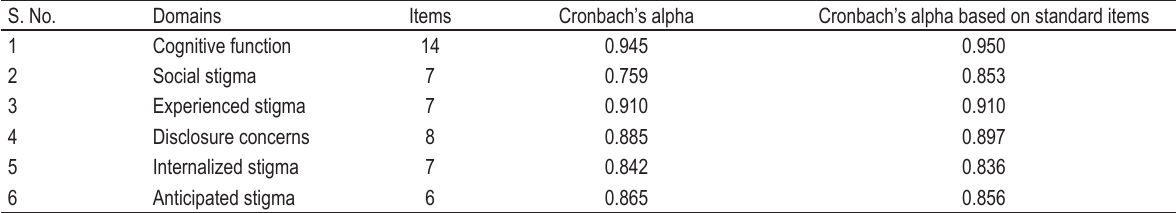
TABLE 2. Reliability of six domains of Stigma in LF (n=80) assessed by Cronbach’s alpha S. No.